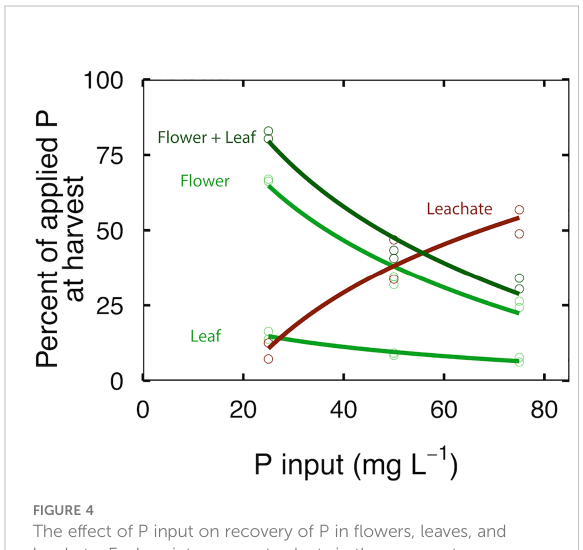
FIGURE 4 The effect of P input on recovery of P in fl owers, leaves, and leachate. Each point represents plants in three separate containers that shared a common leachate collection tray. Curves represent second order polynomial functions fi tted to the